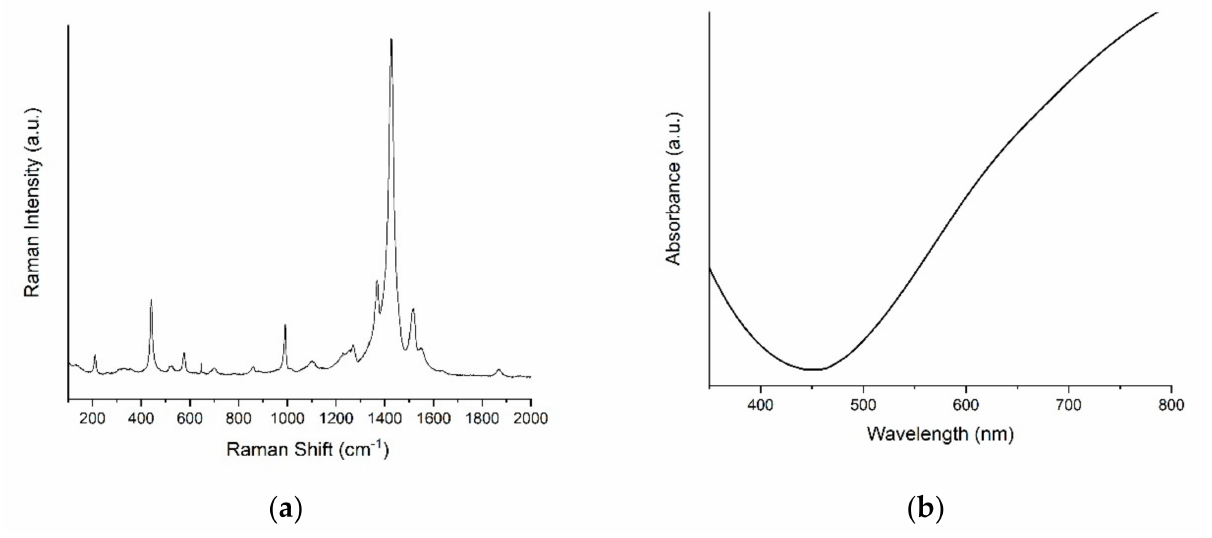
Figure 4. ( a ) Raman spectra of PEDOT/Pd, ( b ) visible spectrum of PEDOT/ITO.